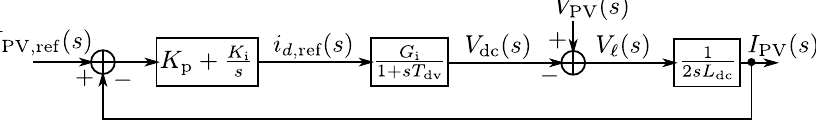
Figure 4. Block diagram of the PV array current closed-loop